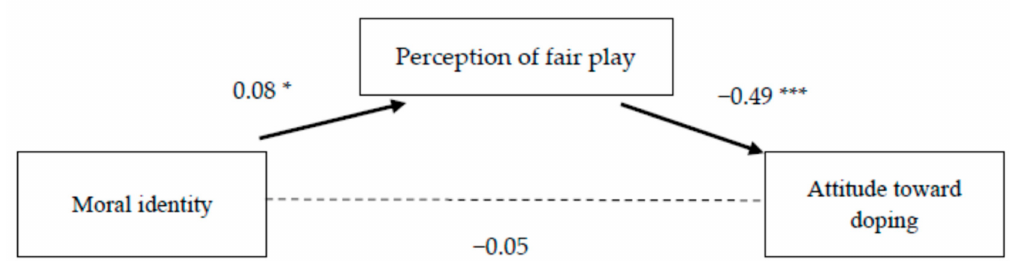
Figure 2. The effects of moral identity on attitudes to doping and the mediating role of perception of fair play among non-athletes. Note: The values presented are the unstandardized regression coefficients. A solid line represents a significant relationship. * p < 0.05; *** p <